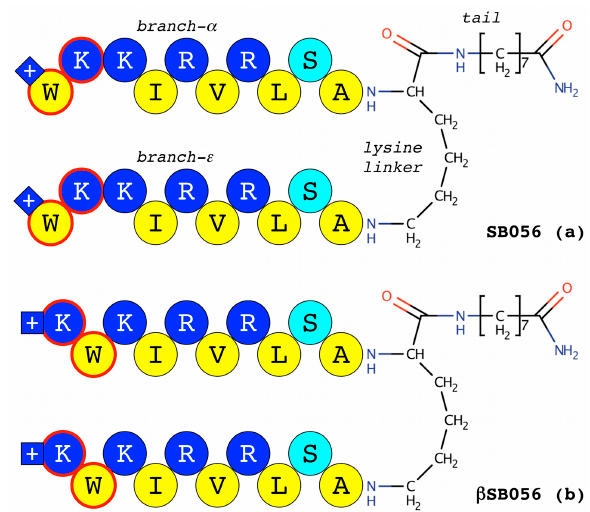
Figure 2. Schematic representation of the branched peptides SB056 and β SB056 (see the main text for the details). Two peptide branches are bonded to the α - and ε -amino group of a lysine residue, i.e., the linker, respectively. An 8-aminooctanamide tail is bonded to the C-terminus of the linker. The residue type is colour coded as follows: hydrophobic in yellow, positively charged in blue and polar uncharged residues in cyan. The positively-charged N-termini are represented by the blue square with the white cross in the middle. The two residues, the position of which was exchanged moving from SB056 to β SB056, are red bordered. From [30]. Reproduced with permission.